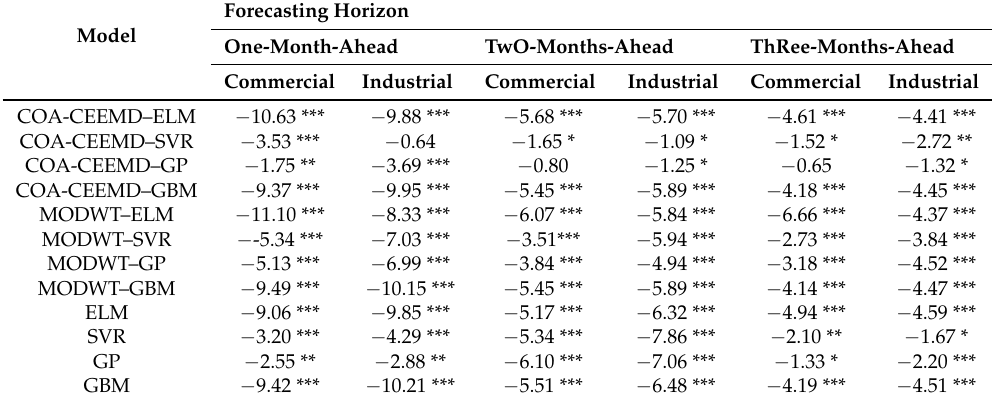
Table 7. Statistic of DM test for statistical comparison of proposed approach versus other models